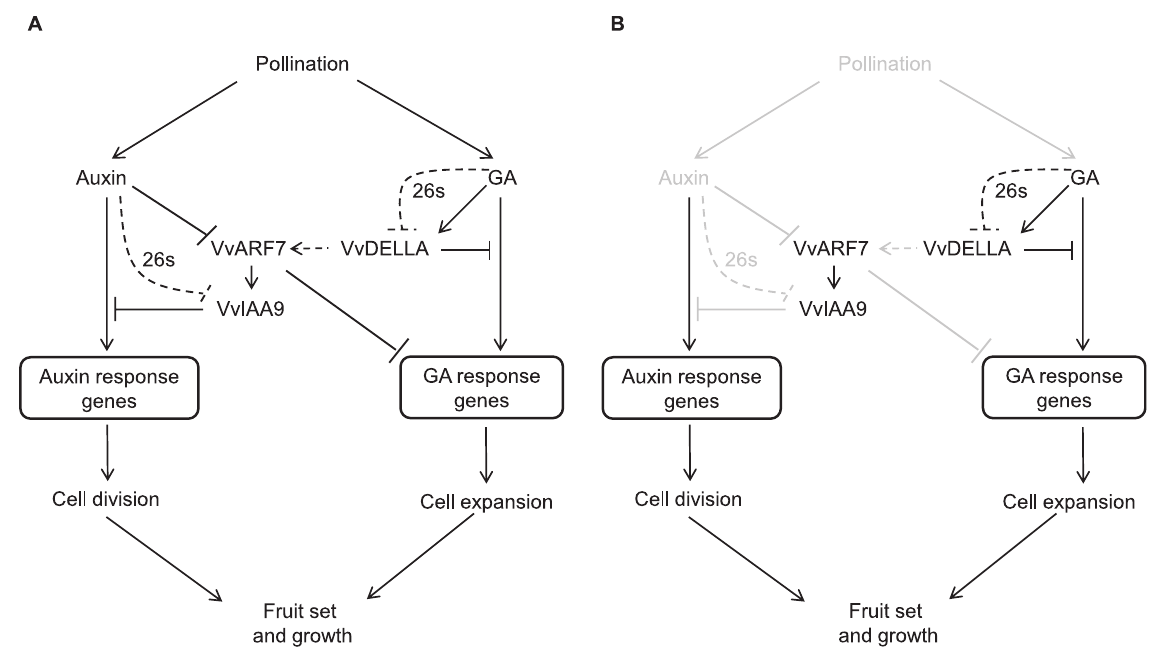
Figure 5. Proposed model for GA and auxin crosstalk in grapevines during fruit set initiation. The possible functions of VvARF7 , VvIAA9 , and VvDELLA are also included, based on de Jong et al. [6] and Carrera et al. [28]. ( A ) Pollination-mediated fruit set initiation. The dashed line with 26S indicates the regulation of protein levels by 26 s proteasome-mediated degradation, and the arrow indicates activation at the protein level. ( B ) Putative hormone signaling in fruit set initiation by GA application on grapevine inflorescences. Pathways inactivated by GA application are indicated in gray.